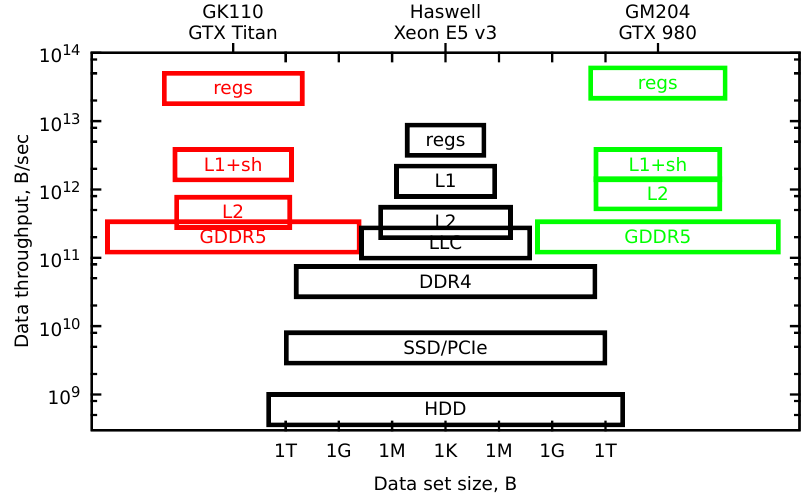
Figure 1. Memory subsystem hierarchy for the GPGPU and